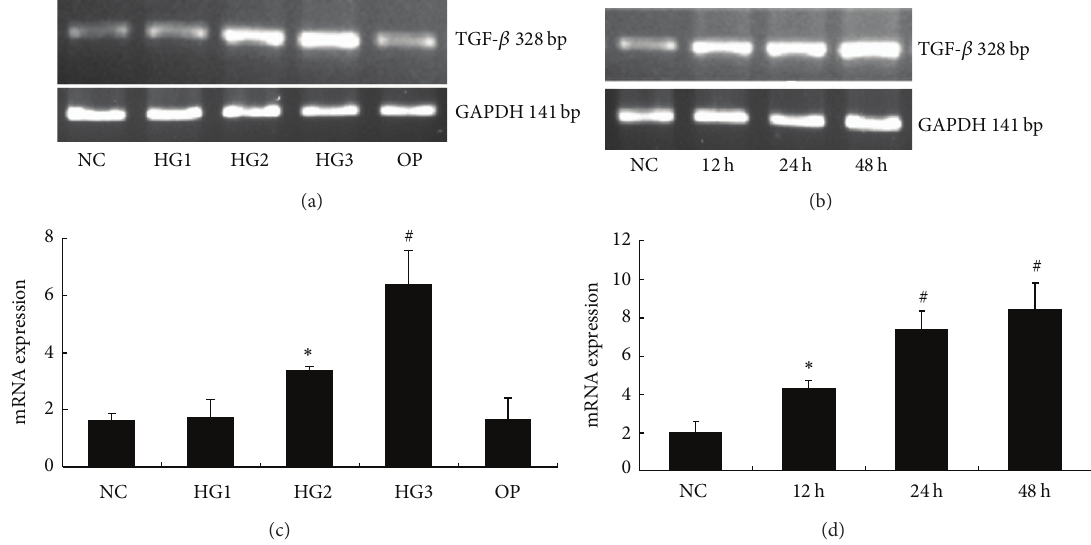
Figure 7: The mRNA levels of TGF- 𝛽 in each group of GMCs. (a) RT-PCR strip chart for different concentrations of glucose. (c) The relative gray value statistics graph of the mRNA level for different concentrations of glucose. (b) and (d) The RT-PCR strip chart and the relative gray value statistics graph of the mRNA level for different times. ∗ 𝑃 < 0.05 versus NC group and # 𝑃 < 0.01 versus NC group.